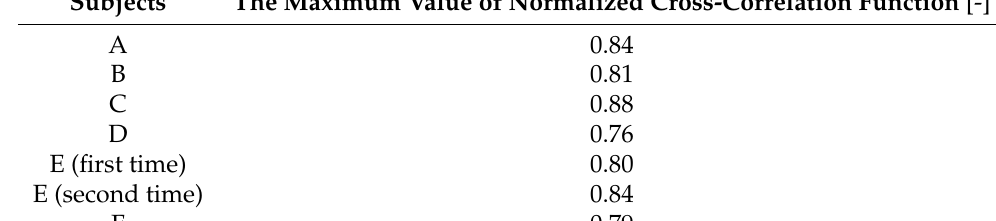
Table 2. The maximum value of normalized cross-correlation function.